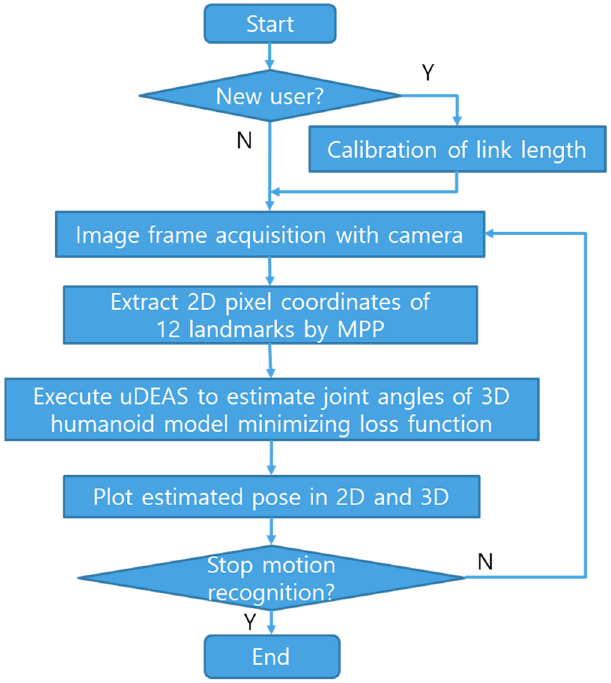
Figure 5. Flow diagram of the proposed pose estimation process.